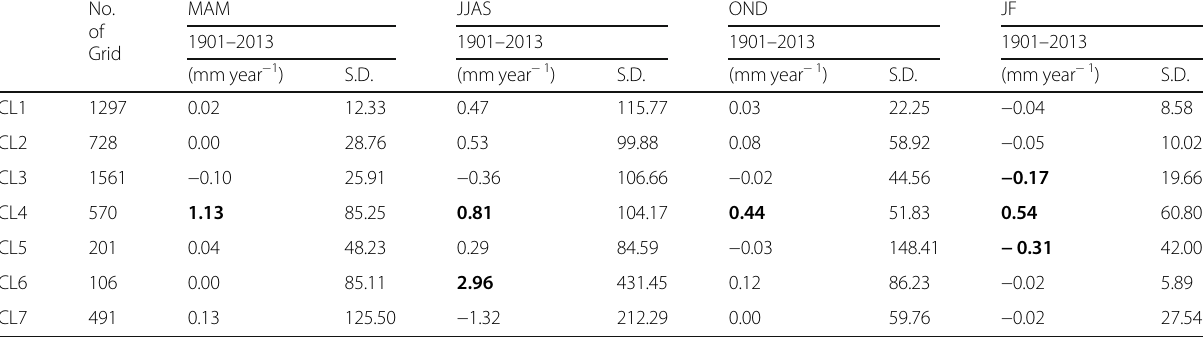
Table 1 Regression coefficient of the long-term trend of seasonal precipitation on each cluster for 1901 – 2013 No.